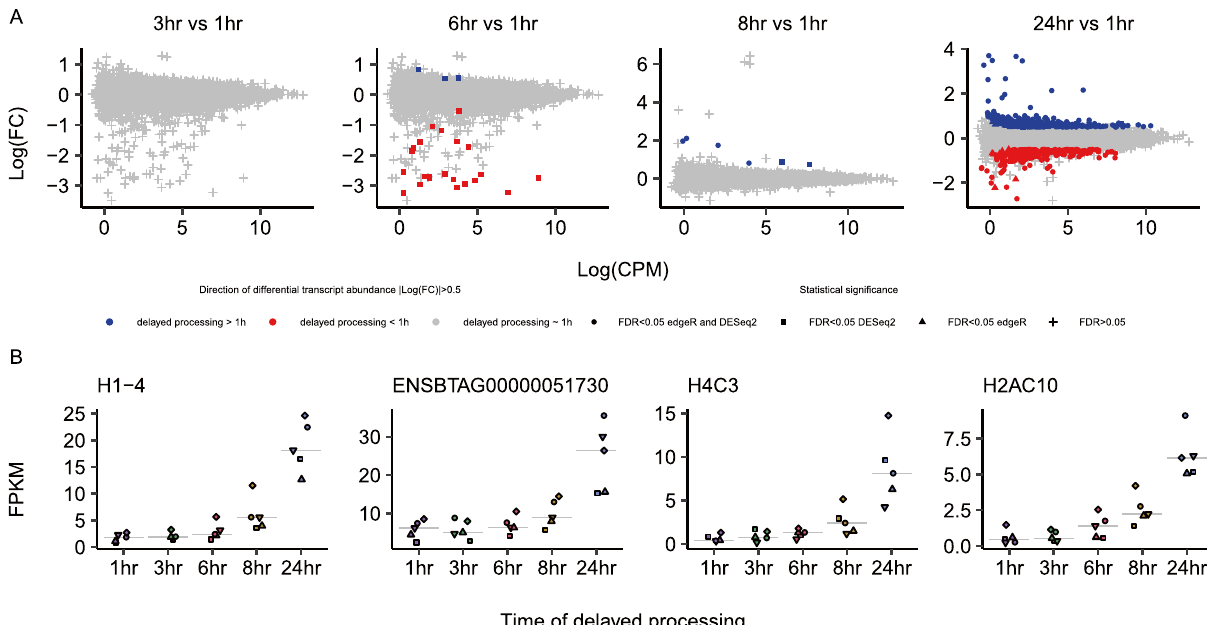
Figure 3. Comparison of transcript abundance in PWBCs from blood samples processed after prolonged storage at 4 °C. ( A ) M-A plots of the contrasts between each of the prolonged storage times versus samples processed within one hour. Gray shapes indicate genes whose transcript abundance are not significantly altered following the preservation of blood samples (FDR > 0.05). Squares indicate genes whose transcript abundance were significantly altered (FDR < 0.05) based on the DESeq2 algorithm. Triangles indicate genes whose transcript abundance were significantly altered (FDR < 0.05) based on the edgeR algorithm. Circles indicate genes whose transcript abundance were significantly altered (FDR < 0.05) based on both DESeq2 and edgeR algorithms. ( B ) Transcript abundance for genes with differential abundance in both the ‘8 h vs 1 h’ and ‘24 h vs 1 h’